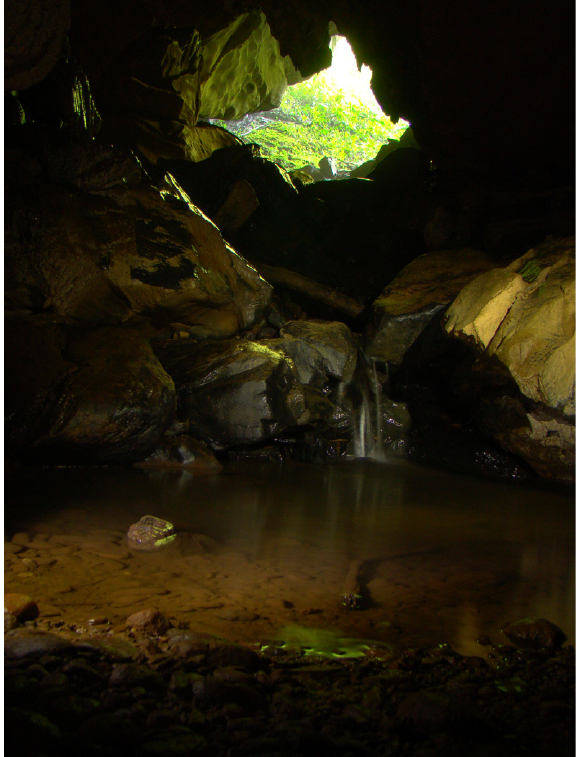
Figure 9. Caverna Paçoca, Iporanga, São Paulo state, Brazil. Photo by P.P.